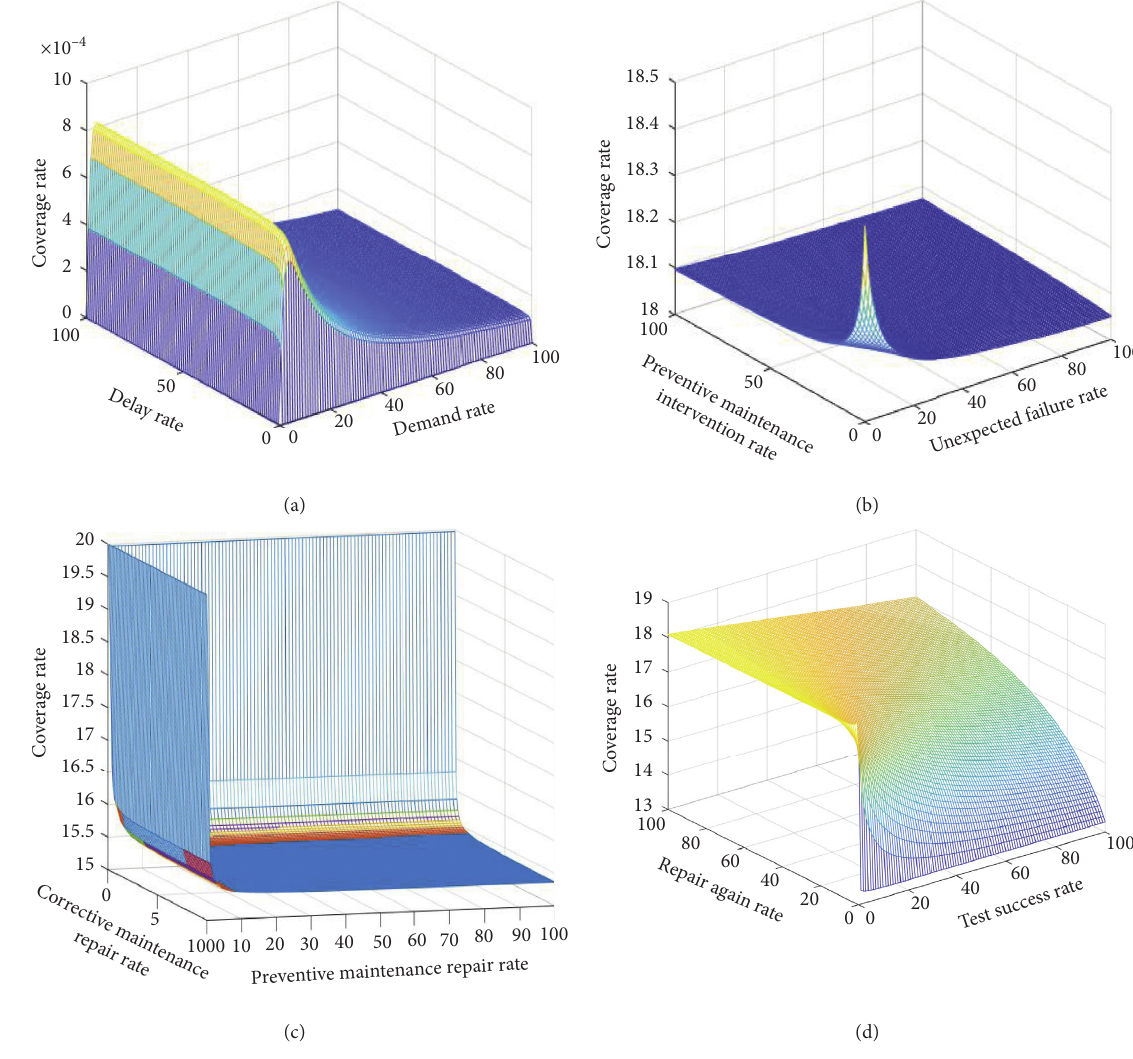
Figure 6: Coverage rate. (a) Variation of demand and delay rates. (b) Rate variation of unexpected failure and maintenance interventions. (c) Repair rate variation for corrective and preventive maintenance. (d) Test rate variation (repair again or